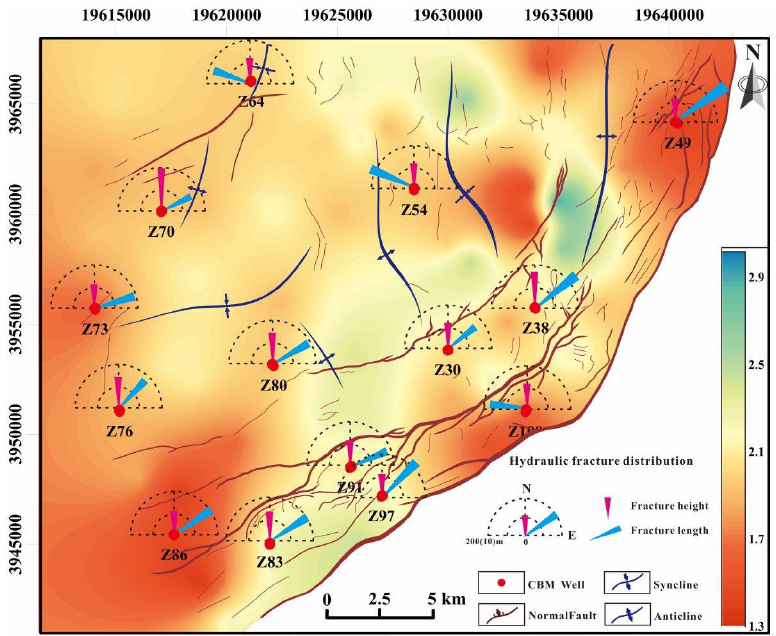
Figure 10. S-Index isovalue map of the No. 3 coal seam in the Zhengzhuang field. Based on the analysis of microseismic data in this region, we obtained the hydraulic fracture propagation of 14 wells (Table 6). Results show that the length and height of the major fractures range from 142.0 to 260.0 m and 6.0 to 9.8 m, respectively. Figure 11a,b reveal the relationship between S-Index and hydraulic frac- turing fractures in the No. 3 coal seam. The fitting chart shows that the fracture height and length are positively and negatively correlated with the S-Index, respectively.